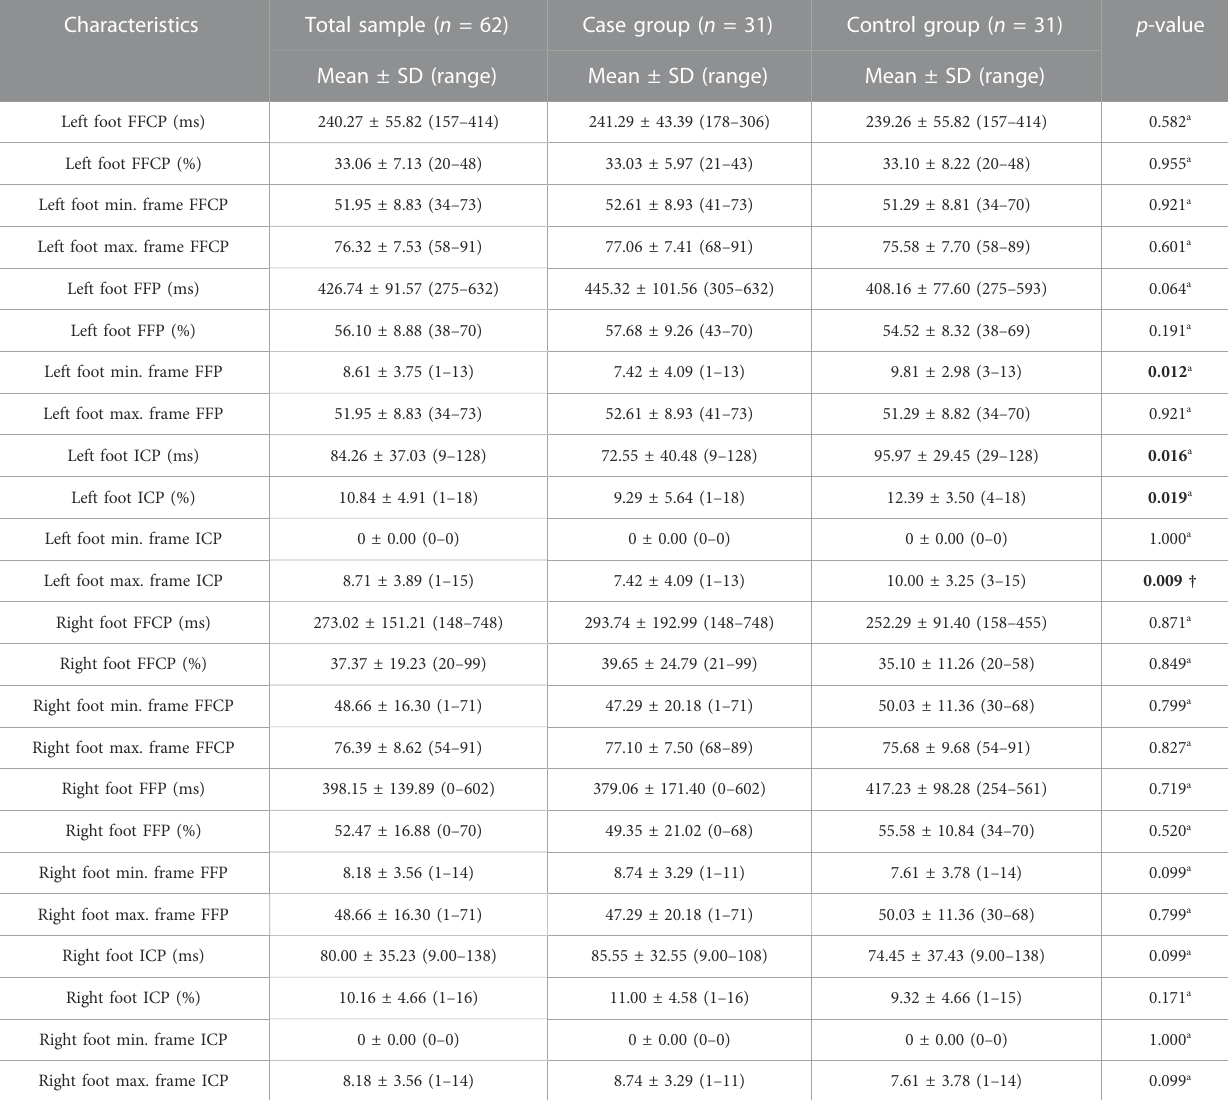
TABLE 2 Main outcome measurements of gait analysis of the total sample with or without bilateral adult fl atfoot.